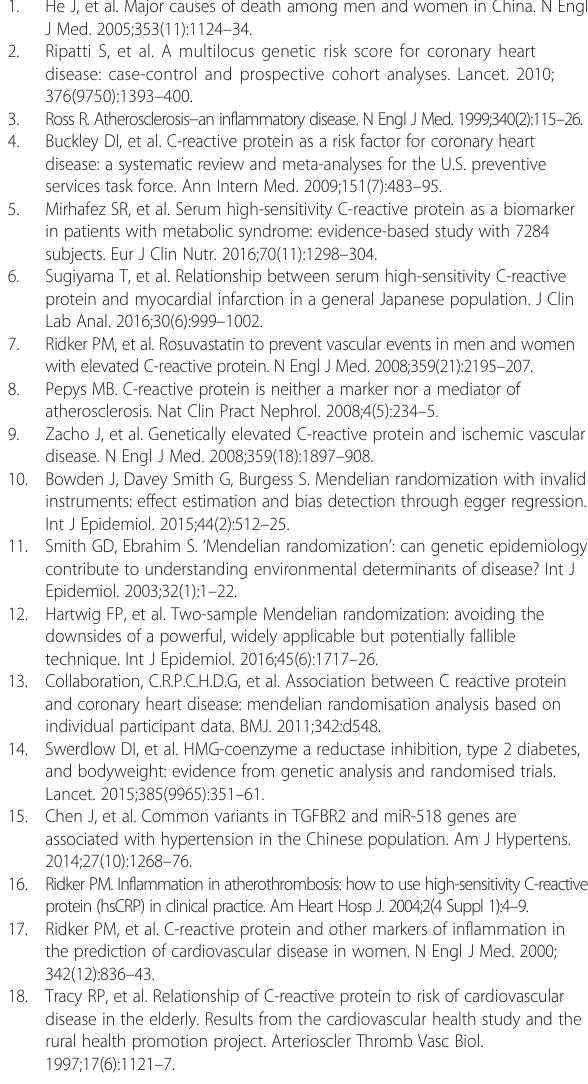
Additional file 1. Table S1. Bioinformatics Analysis of 4 selected SNPs in CRP Gene. Table S2. Stratification analysis of CRP gene polymorphisms and CHD. Table S3. Partial correlation analysis of CRP variation with hs- CRP. Figure S1. Survival ROC analysis for hs-CRP and CHD incidence.